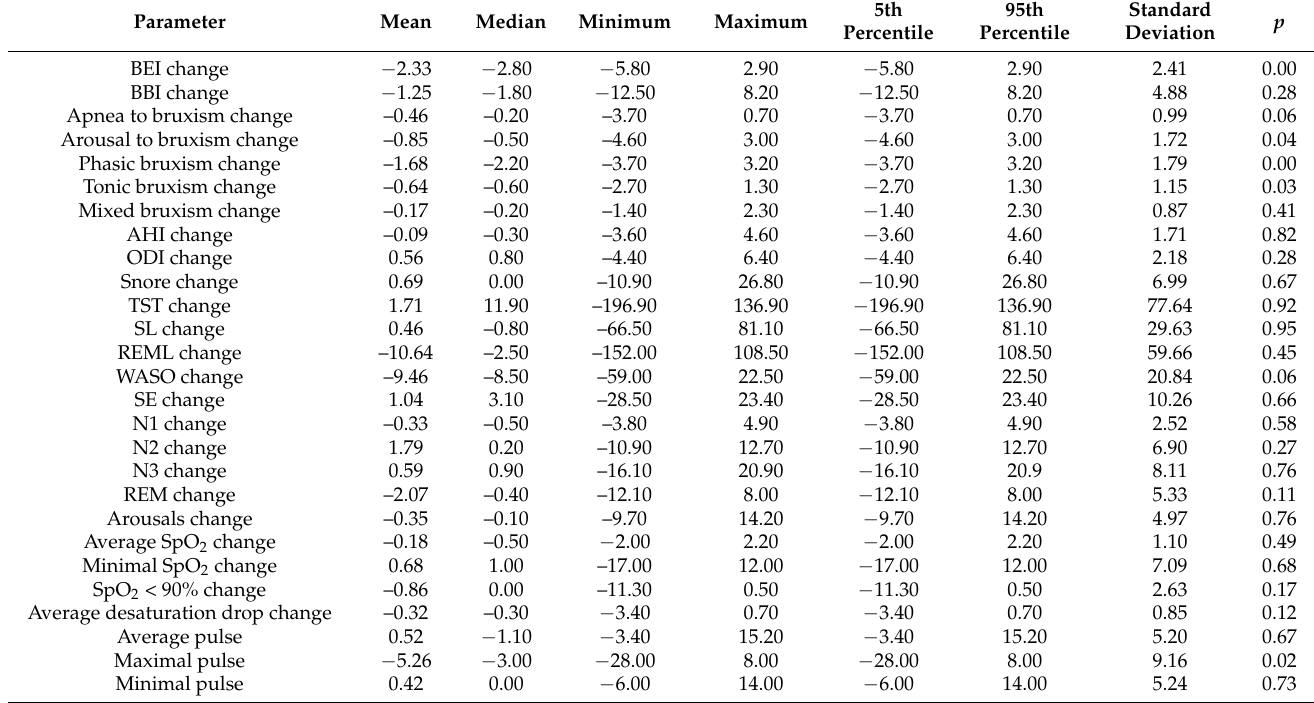
Table 3. Change in the studied parameters after pharmacotherapy (N =